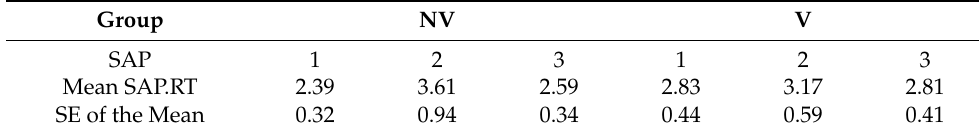
Table 7. SAP response time (in seconds), divided by group and SAP number.